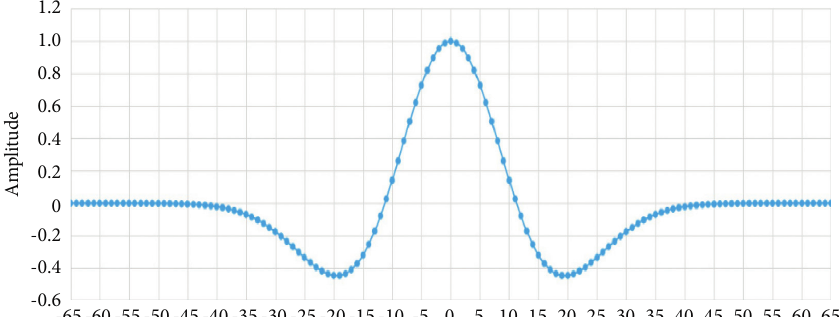
Figure 10: Ricker wavelet at